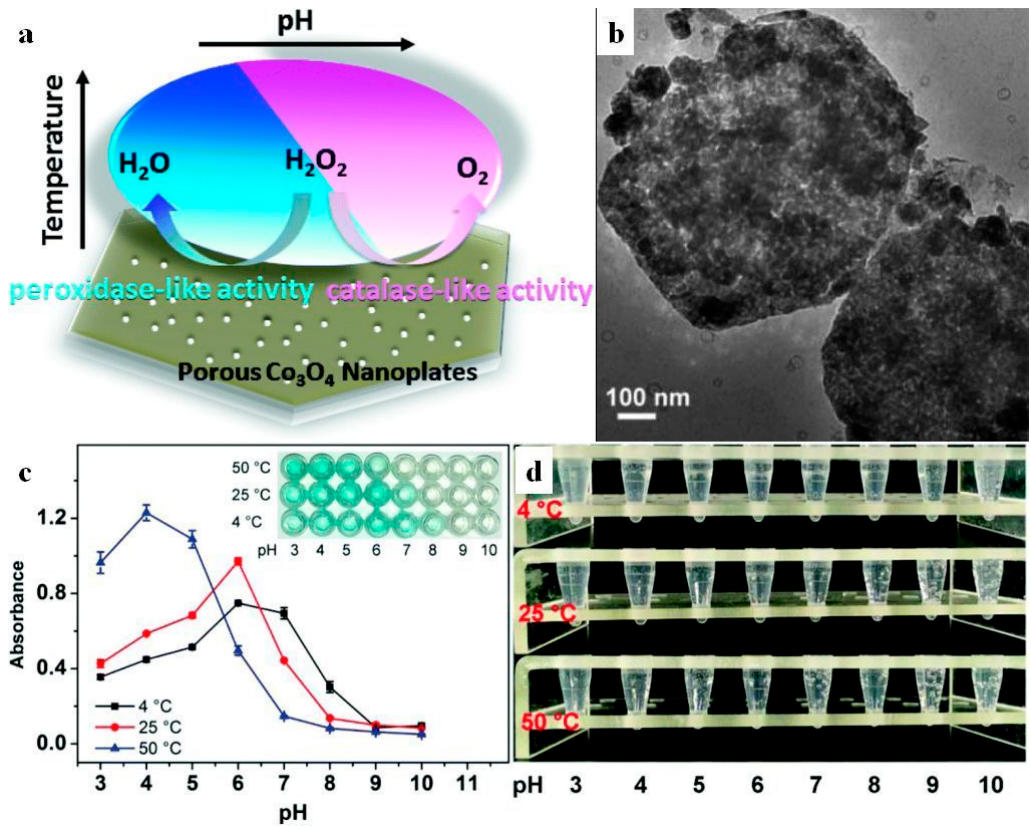
Figure 3. Schematic representation of the multienzymatic activity of porous Co 3 O 4 flakes ( a ) captured on TEM micrograph ( b ), the peroxidase activity of the nanoflakes in TMB assay with visual representation as inset photograph ( c ) and its O 2 evolution through catalase activity ( d ). Reproduced from Reference [107] with permission from the Royal Society of Chemistry.